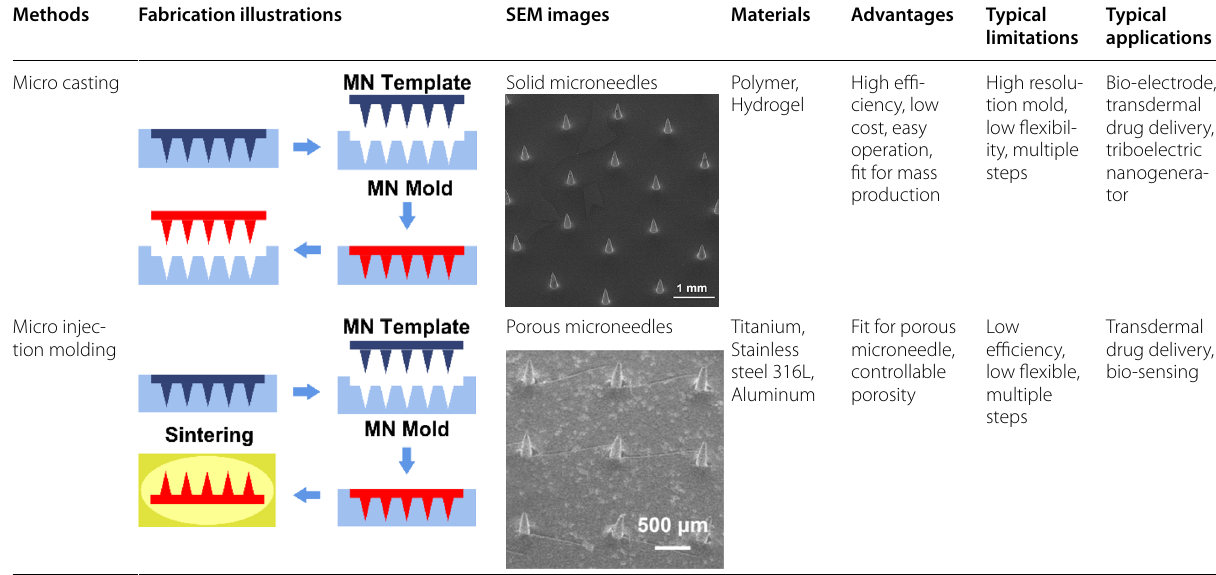
Table 6 Formative manufacturing of microneedles Methods Fabrication